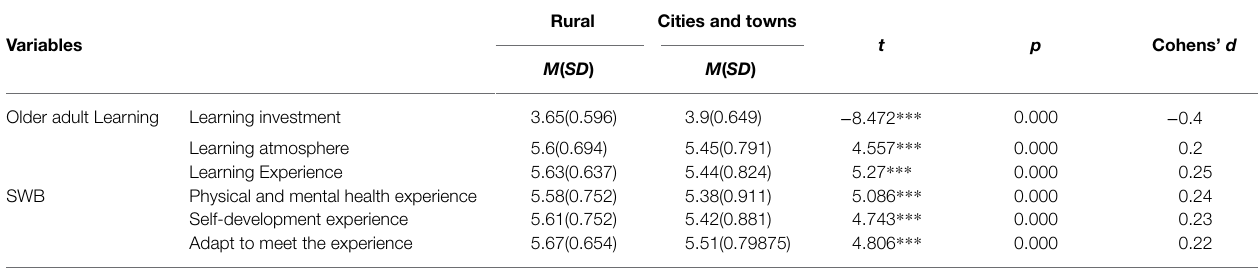
TABLE 8 | Results of independent-samples t -test ( n = 2007).